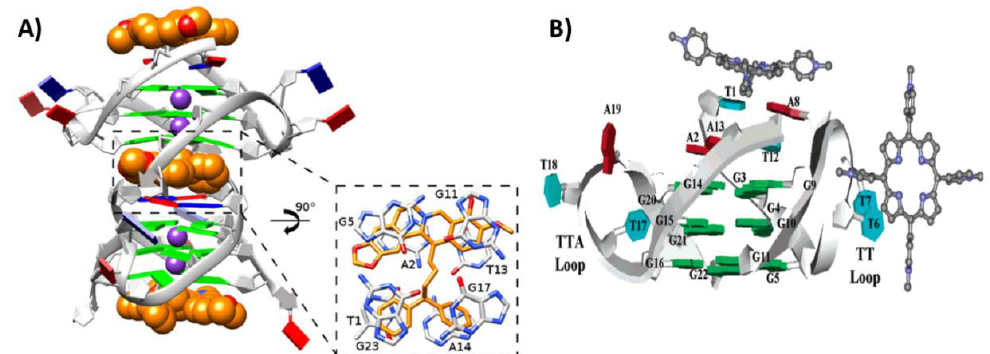
Figure 5. ( A ) Crystal structure of the complex between the bimolecular parallel G-quadruplex h-tel12 of sequence d(TAGGGTTAGGGT) and NAX053 [54]. ( B ) Crystal structure of the complex between the bimolecular parallel G-quadruplex h-tel11 of sequence d(TAGGGTTAGGG) and TMPyP4 [59]. In ( A ) the G-quadruplex, units are 5′ - 5′ stacked, while , in ( B ) the 5′ - and 3′ -ends of the G-quadruplex, they are at the top and bottom, respectively. Adapted with permission from refs. [54,59], Copyright 2016 WILEY-VCH Verlag GmbH & Co. KGaA, Weinheim and Copyright 2007 American Chemical Society.